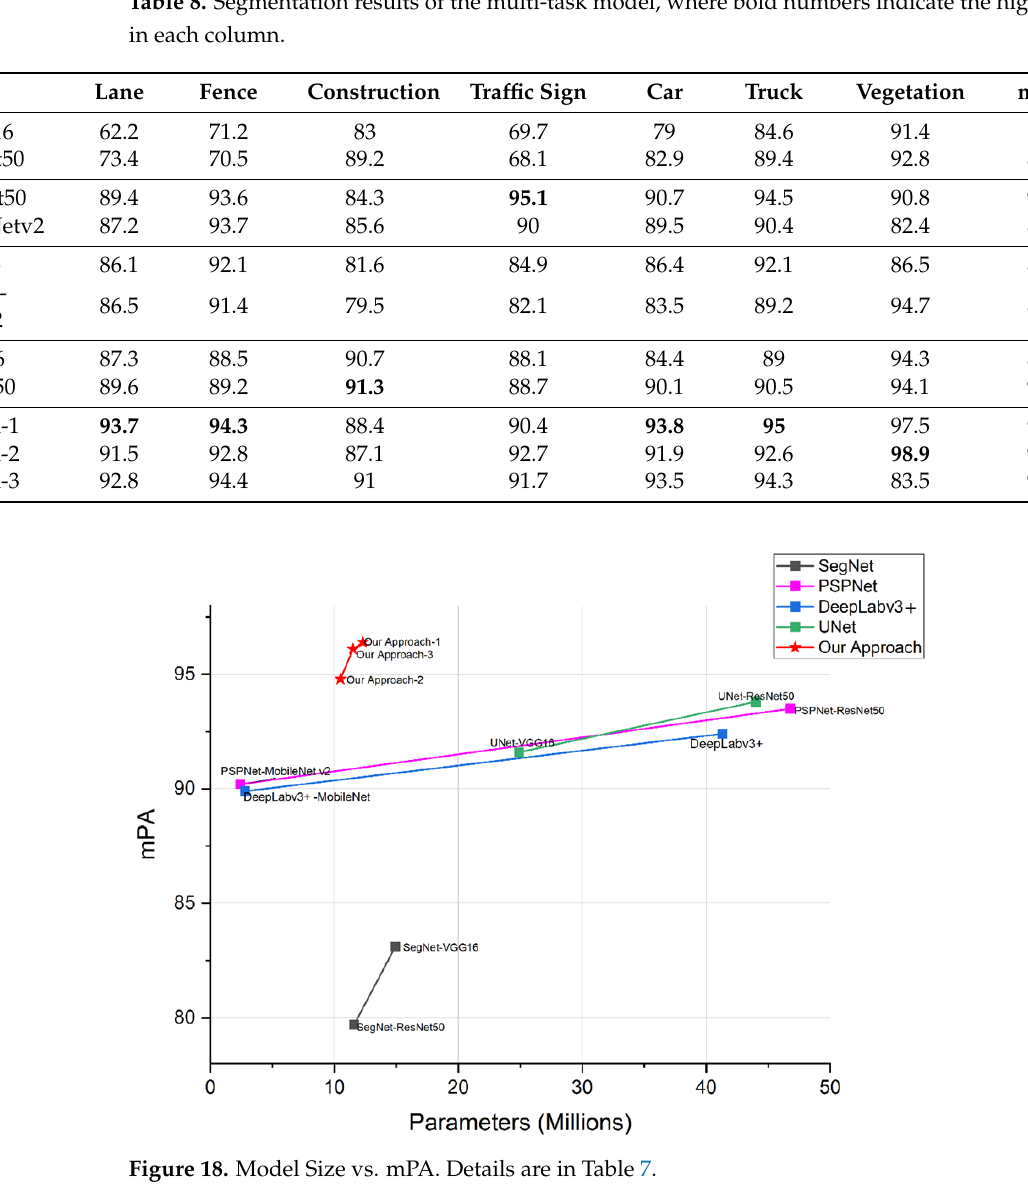
Figure 18. Model Size vs. mPA. Details are in Table 7.